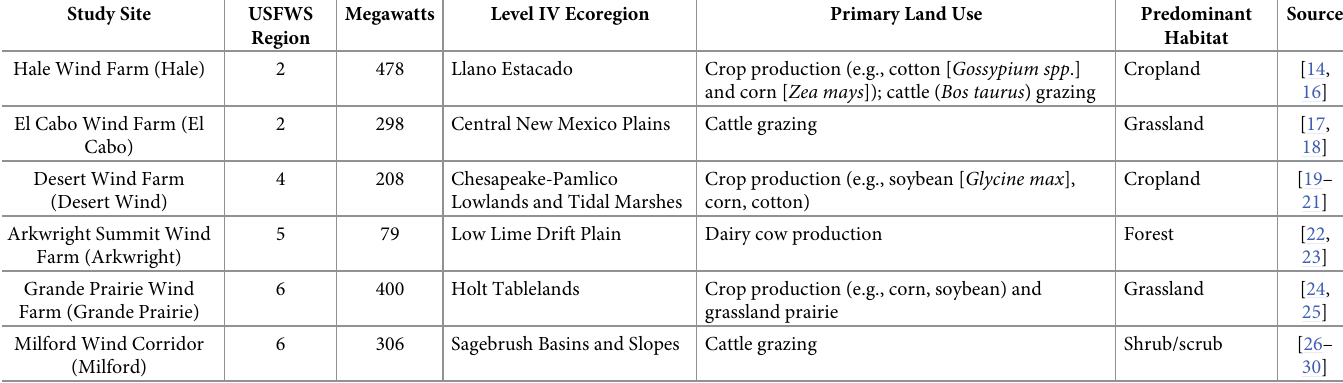
Table 1. Study site descriptions for the carcass persistence study conducted from June 2020 to August 2021. Study Site